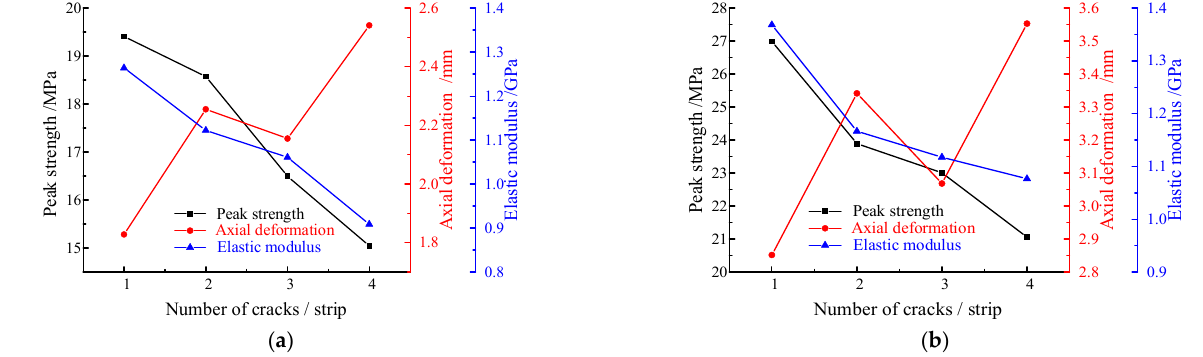
Figure 5. Variation curves of basic mechanical parameters of fractured coal specimens under different confining pressures. ( a ) Confining pressure 0.3 MPa; ( b ) confining pressure 3 MPa.